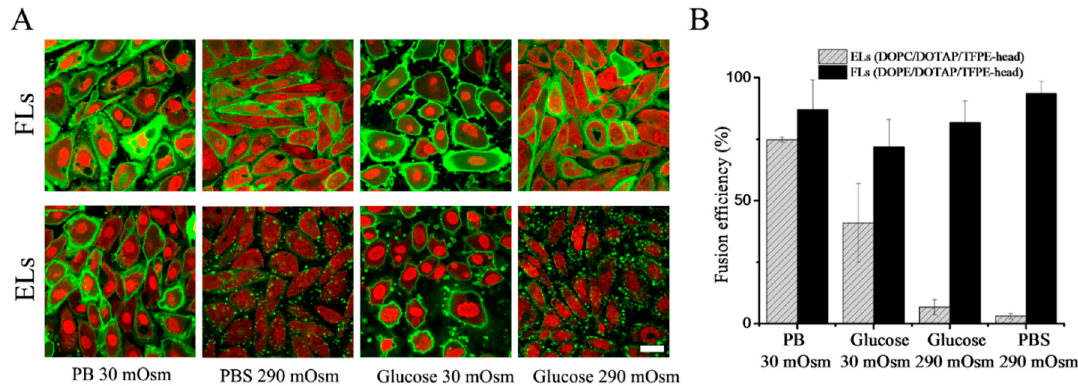
Figure 4. ( A ) Fluorescence micrographs of CHO cells after treatment with fusogenic (DOPE / DOTAP / TFPE-head 1 / 1 / 0.1 mol / mol) upper row, and endocytic liposomes, (DOPC / DOTAP / TFPE-head 1 / 1 / 0.1 mol / mol) lower row. Green: TFPE-head signal, red: Nucleic staining with DRAQ5. Scale bar, 20 µ m, applies to all. ( B ) Fusion e ffi ciencies. Whiskers indicate standard deviations of at least three independent experiments. Table 4. Fusion e ffi ciencies of liposomes containing the cationic lipid DOTAP, di ff erent helper lipids, and TFPE-head as a dye molecule (1 / 1 / 0.1 mol / mol) depending on the osmolality of the solution at 37 ◦ C. Average values of at least three independent experiments and their standard deviations are given. Fusion E ffi ciency % Liposomal Composition